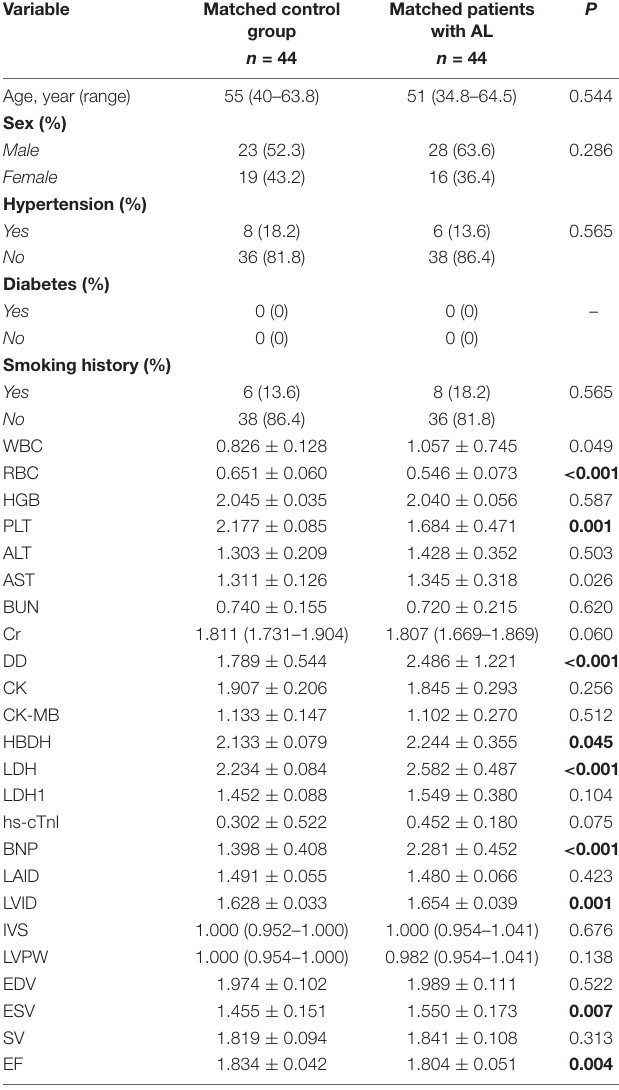
TABLE 2 | Multivariate association of clinically relevant indicators between AL and control groups (related variables). Risk factors